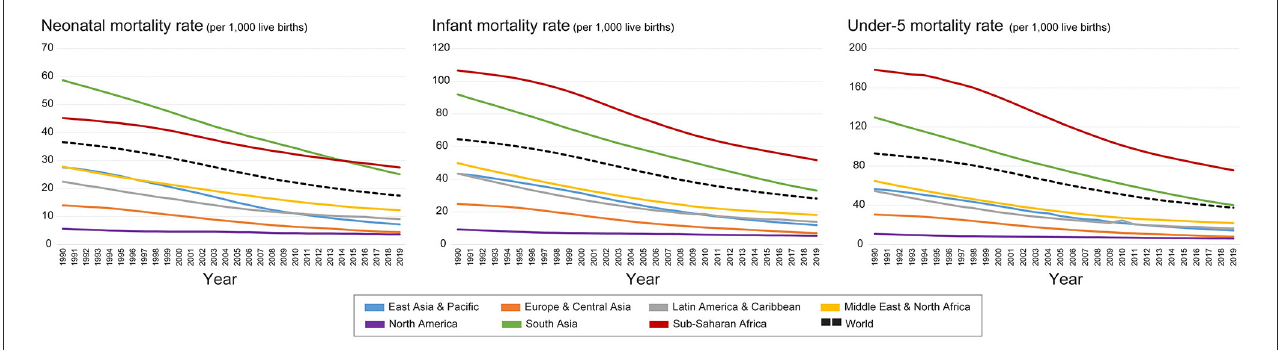
FIGURE2 Change of NMR, IMR, and CMR in the world and different regions by UNICEF from 1990 to